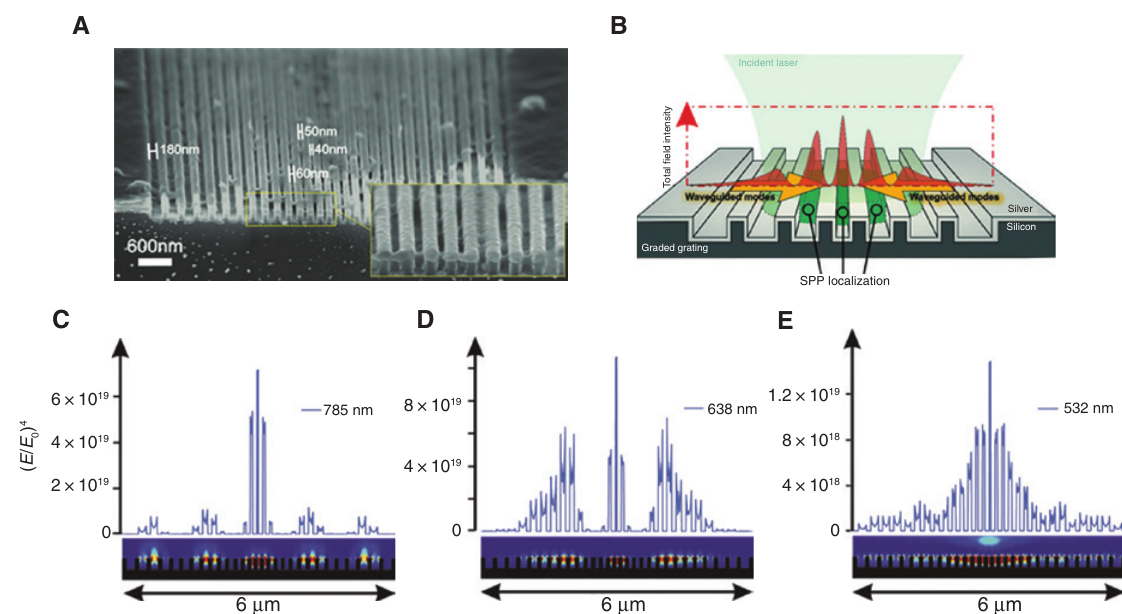
Figure 9: A multiresonant plasmonic system based on the optical coupling between delocalized plasmonic modes [161]. (A) The SEM image of a width-graded rainbow trapping 1D plasmonic nanograting consisting of 29 in-plane MIM rectangular grooves separated from each other by 100 nm thick mesas. All grooves have the same depth of 100 nm. However, their widths increase form 40 nm at the center to 180 nm in both ends in increments of 10 nm. (B) The system schematic diagram. The darker green areas inside the central grooves represent the trapped fields as a result of SPP coupling. Also, the two orange arrows indicate the light guiding in the direction of increasing refractive index toward the center. (C–E) Electric field enhancement factor (| E / E | 4 ) patterns in the system for TM-polarized laser 0 excitations at three different wavelengths: (C) 785, (D) 638, and (E) 532